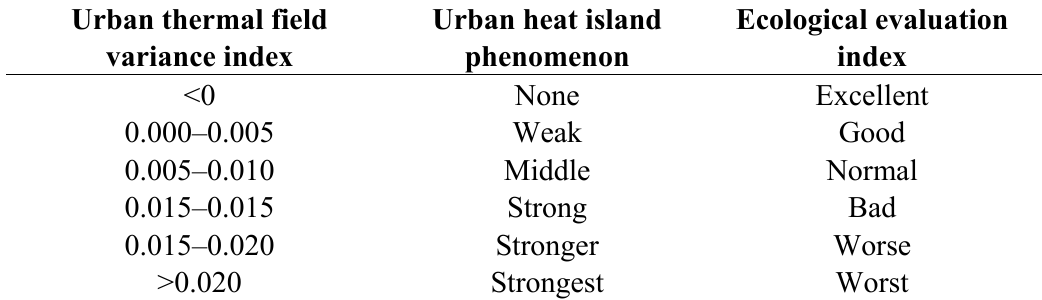
Table 8. The threshold of ecological evaluation index.